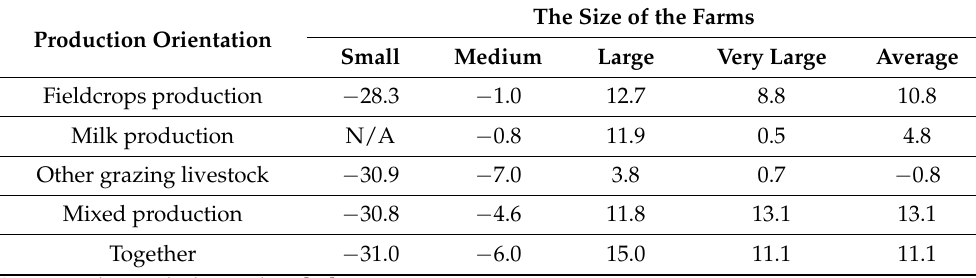
Table 10. Profitability revenues ratio—ROR (2015–2020 average) in percentage.